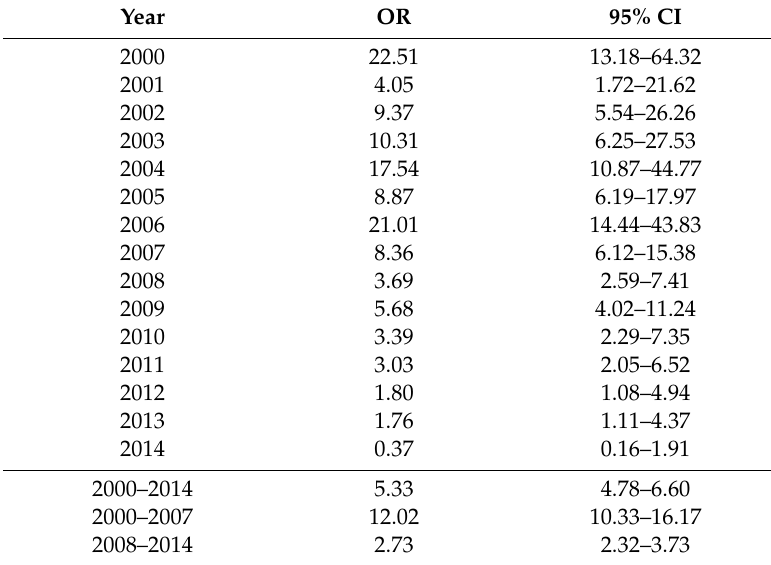
Table 3. Annual odds ratios for STIs in non-native populations versus native populations aged between 15 and 64 years old. Granada, Spain, 2000–2014. Year OR 95%